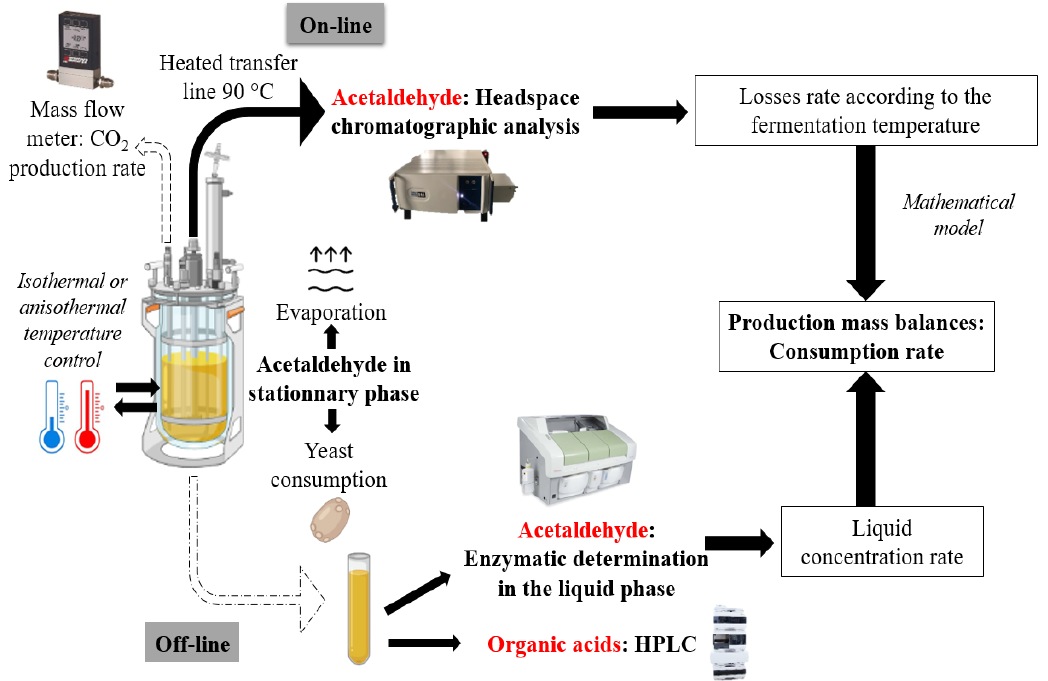
Figure 1. Schematic overview of the experimental design: acetaldehyde production balance during alcoholic fermentation .